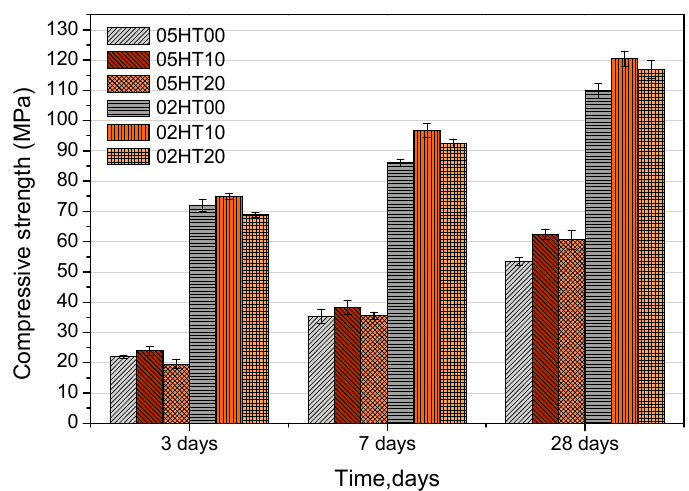
Figure 5. Comparison of compressive strength of samples with different Hwangtoh powder contents.